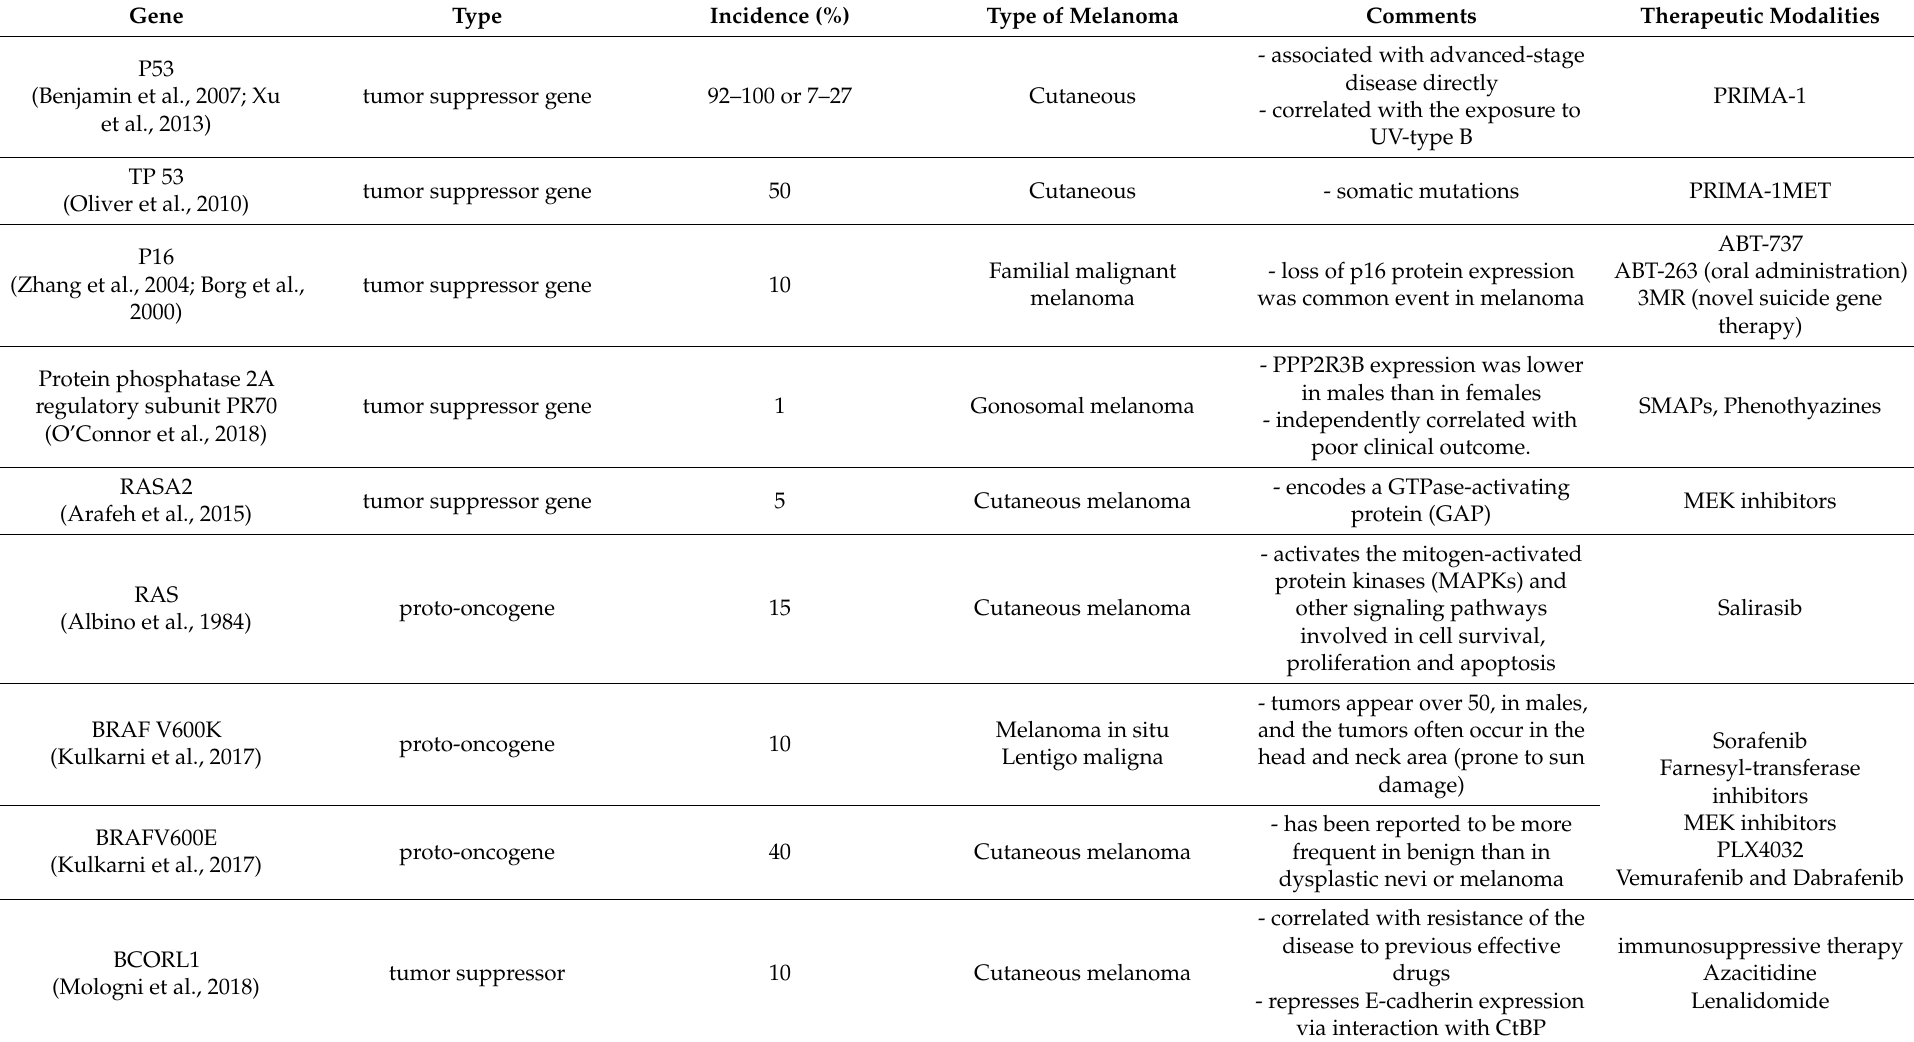
Table 1. Gene mutations in